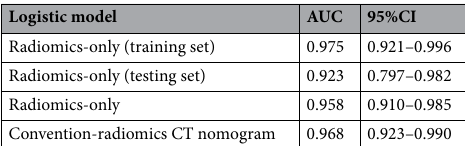
Table 2. The accuracy of differentiated logistic models.